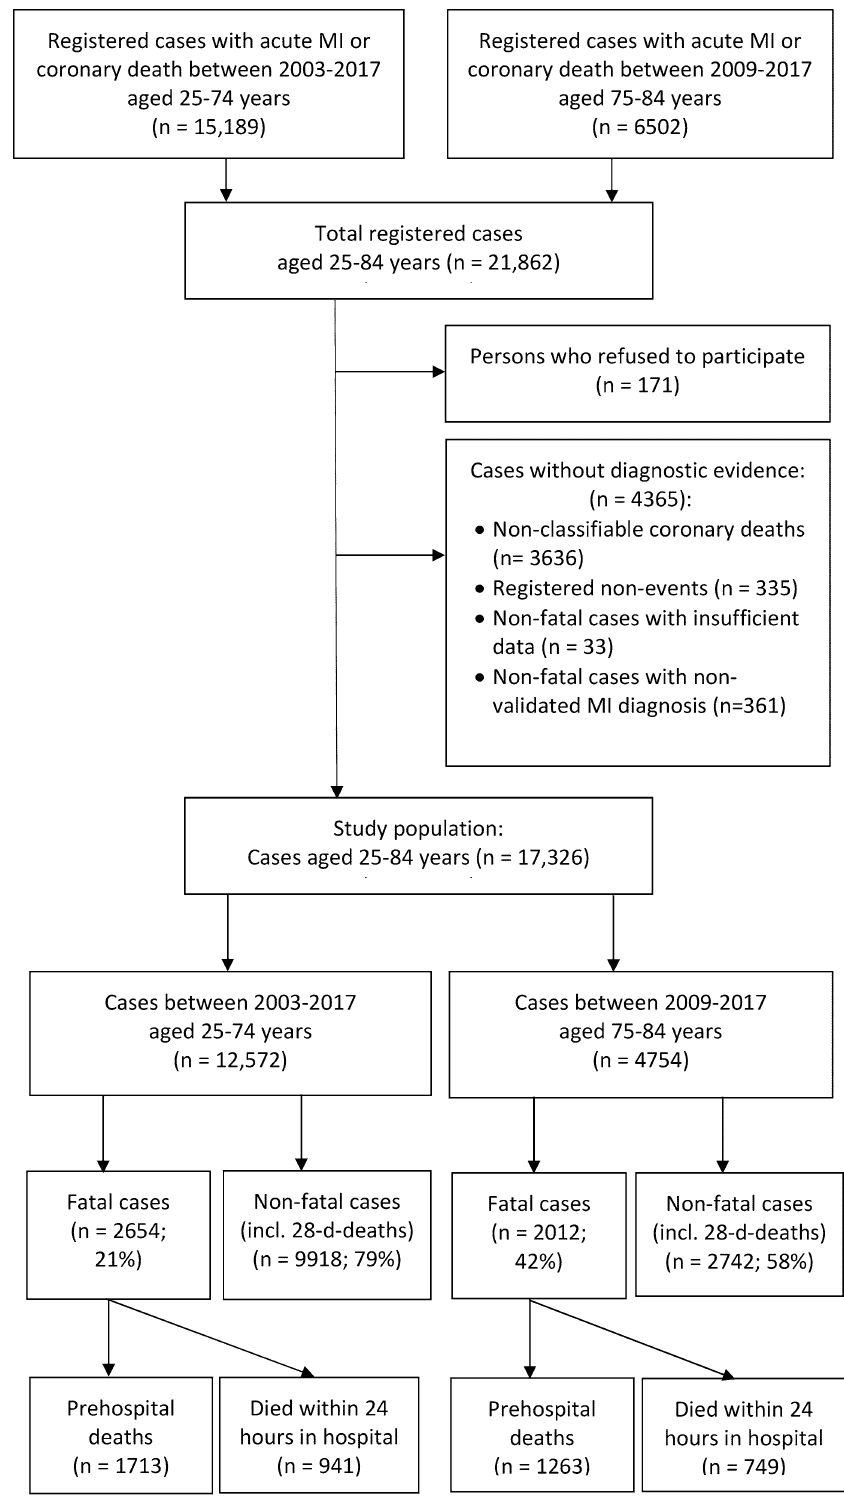
Figure 1. Study population (n = 17,326) from the KORA Myocardial infarction (MI)